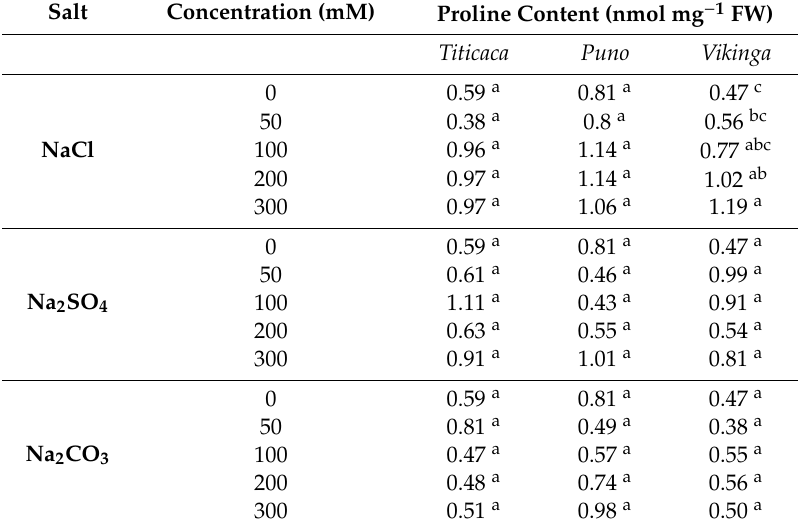
Table 1. Proline content of Titicaca , Puno and Vikinga cultivars under NaCl, Na 2 SO 4 and Na 2 CO 3 stress after 5 days of germination. Di ff erent letters in the same column mean significant di ff erences between treatments, according to Tukey test ( p <